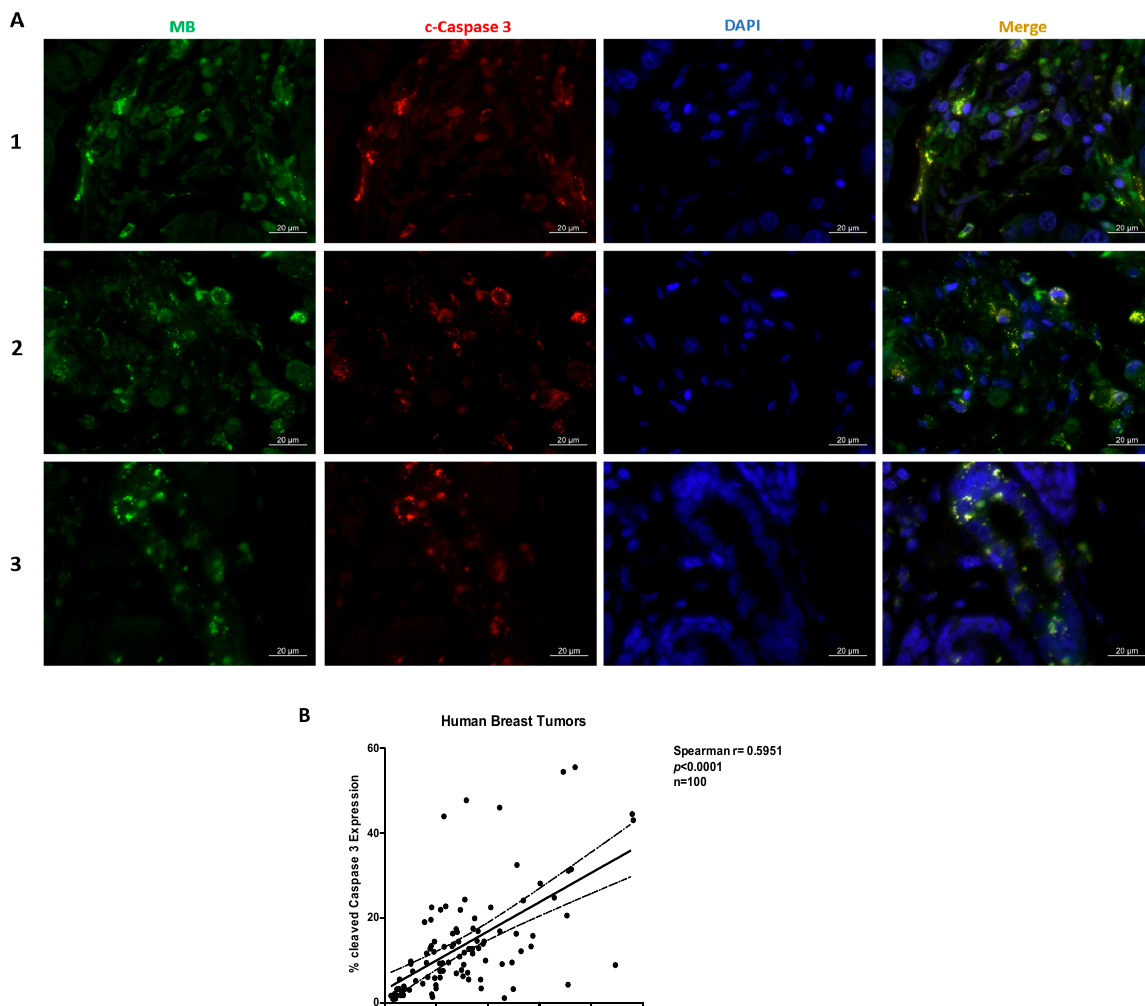
Figure 5. Expression of myoglobin in human invasive ductal carcinoma tumors correlates with increased cleaved caspase 3 expression in vivo. ( A ) Representative immunofluorescence image analysis of the expression of MB (green), cleaved caspase 3 (red), and DAPI (blue) from breast tissue microarray of human invasive ductal carcinoma tumors that are estrogen and progesterone receptors positive. Scale bar is 20 µm. ( n = 100). ( B ) Correlation analysis of % of stains signal areas normalized to tissue areas ( n =